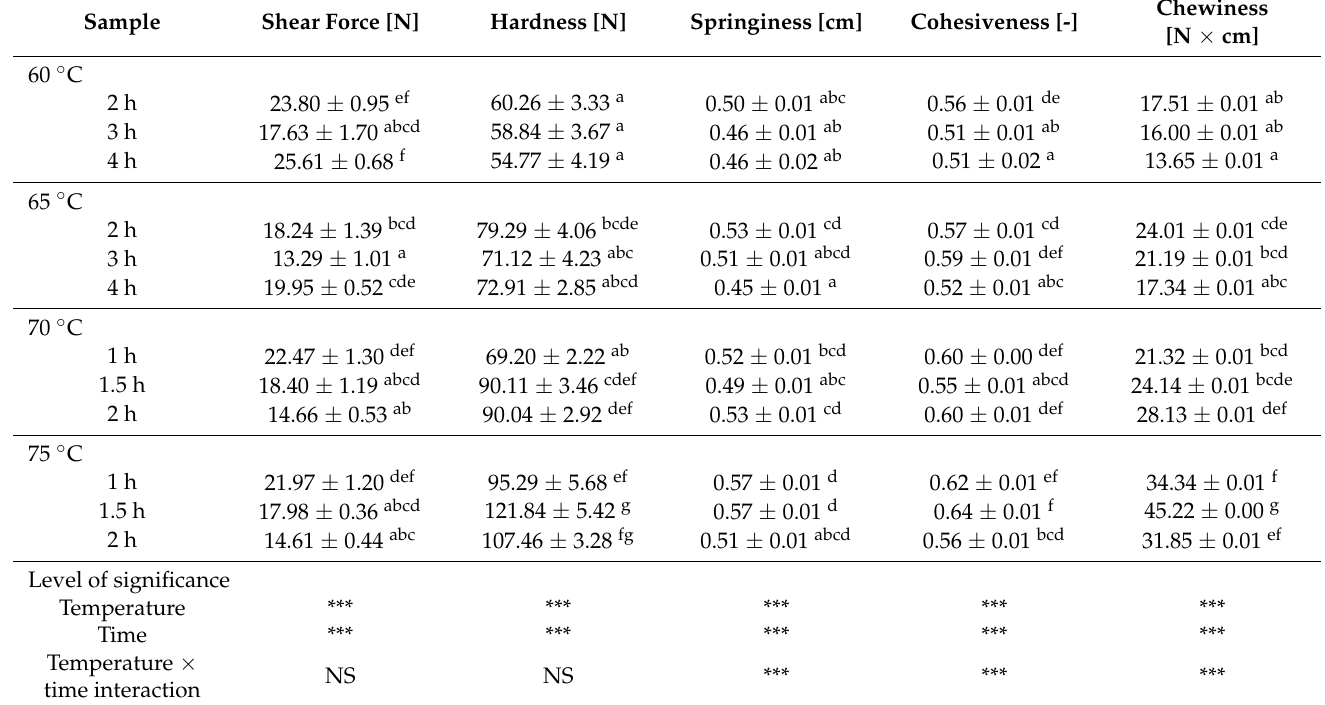
Table 3. Texture characteristics of sous vide cooked pork loin on the basis of shear force and TPA test (mean ±